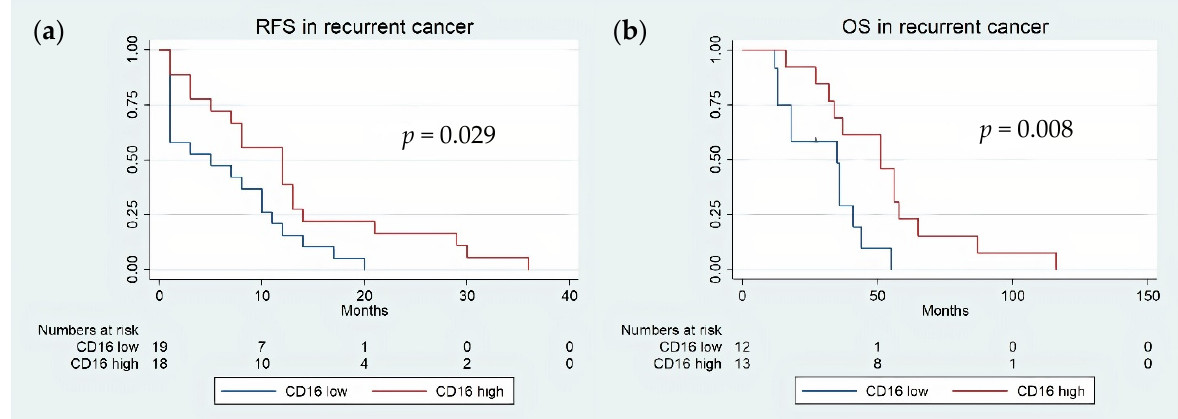
Figure 2. ( a ) Kaplan–Meier survival curve of recurrence-free survival according to CD16 tumor-infiltrating immune cell density in recurrent ovarian cancer biopsies. ( b ) Kaplan–Meier survival curve of overall survival according to CD16 tumor-infiltrating immune cell density in recurrent ovarian cancer biopsies. Red line indicates tumors with high CD16 TIC density, whereas blue line refers to tumors with low CD16 TIC density. Table 4. Uni- and multivariate Hazard Cox regression analysis of OS in recurrent ovarian cancer.